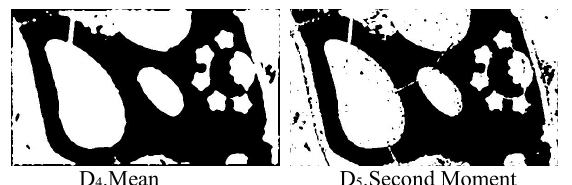
Figure 2. The results of the water extraction